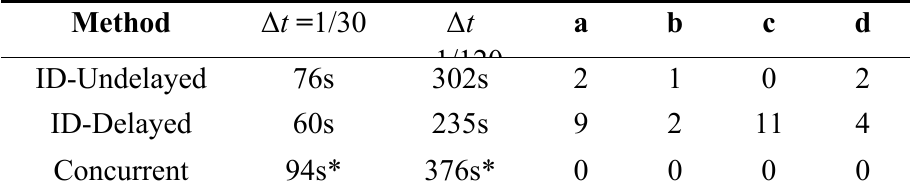
Table 3. Execution time & Failed